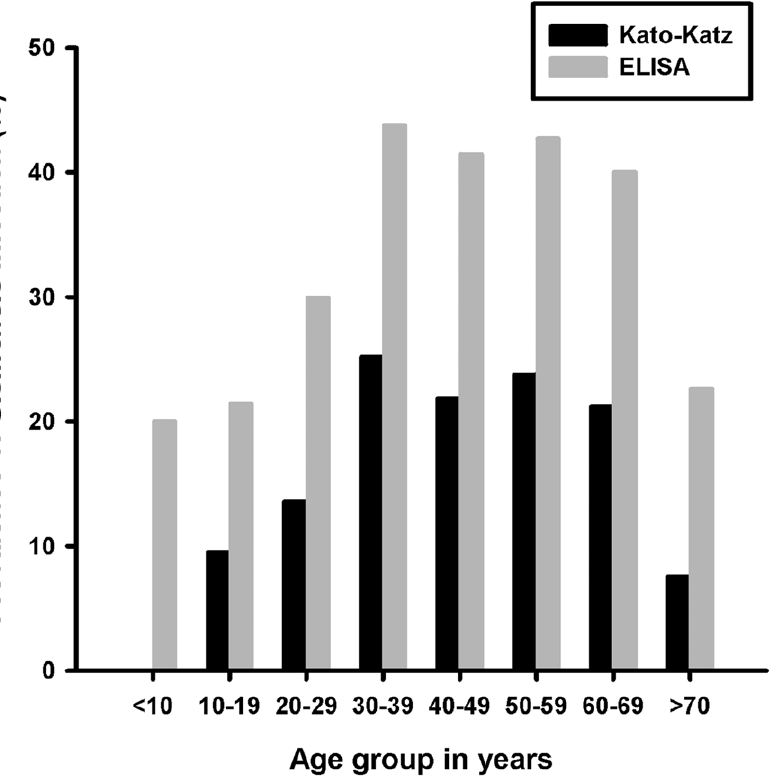
Figure 3. Prevalence of Clonorchis sinensis infection in different age group by Kato-Katz and ELISA examinations. doi:10.1371/journal.pone.0046977.g003 PLOS ONE |